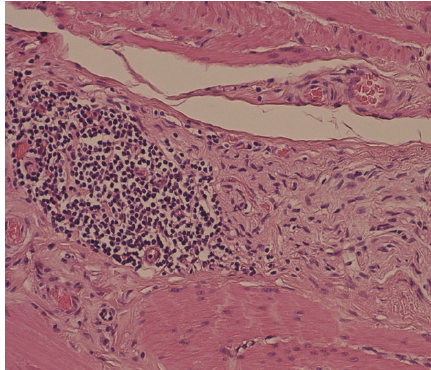
Figure 2: Intermesenteric plexus of the abnormal stomach. Nerve infiltrated by lymphocytes and devoid of ganglion cells. (Haema- toxylin-Eosin, ×